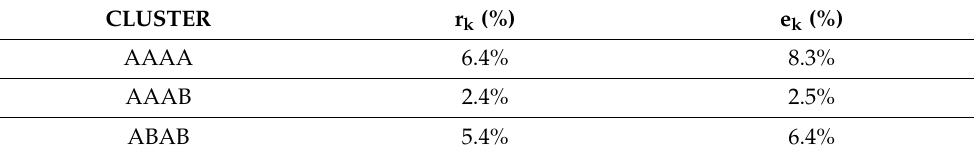
Table 3. The residual, r k , P ( (cid:98) Y k ) , and the error, e k , P ( (cid:100) Y k , m ) , of power profile estimator (cid:98) Y k